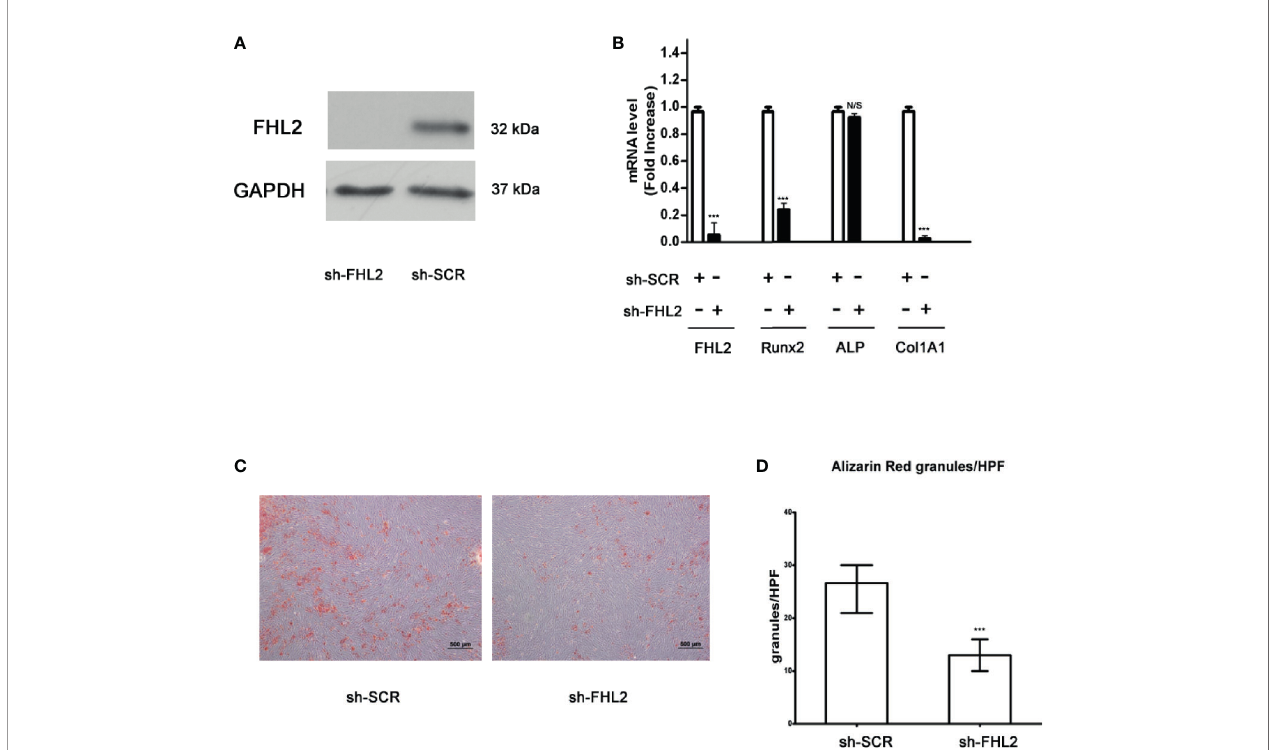
FIGURE 2 | Knocking down of FHL2 impairs Bzb-induced osteoblast differentiation of MM-MSCs. MM-MSCs were infected with shFHL2 and shSCR. (A) FHL2 protein levels were determined by Western blot. (B) Infected cells were cultured for 7 days with 2 nM Bzb with osteogenic induction medium (OBI). mRNA levels of FHL2 and osteoblast markers Runx2, ALP, and Col1A1 by quantitative RT-PCR. (C, D) Infected cells were cultured for 21 days with 2 nM Bzb with osteogenic induction medium (OBI) and 21 days. Alizarin red staining (C) was performed, and alkaline phosphatase index (API) (D) was determined. Results are expressed as